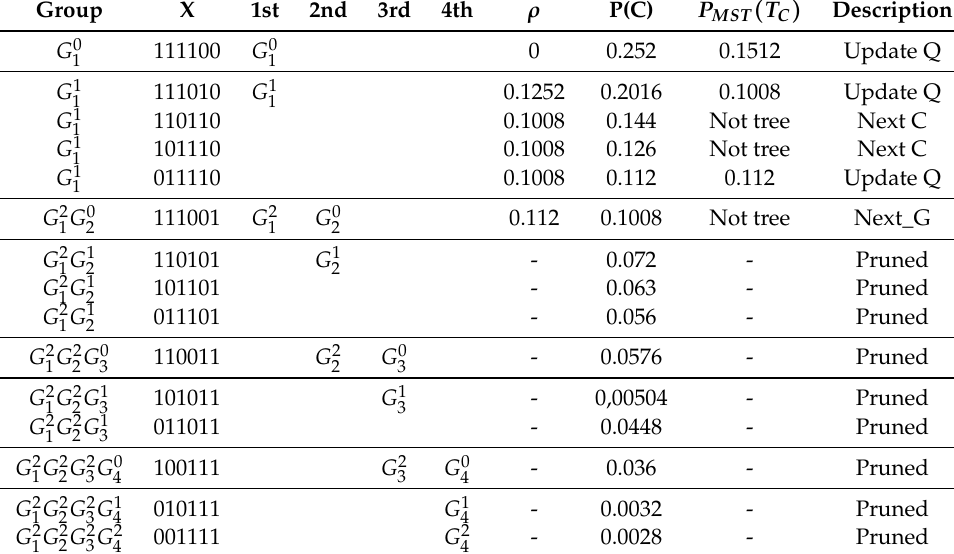
Table 2. A running example of